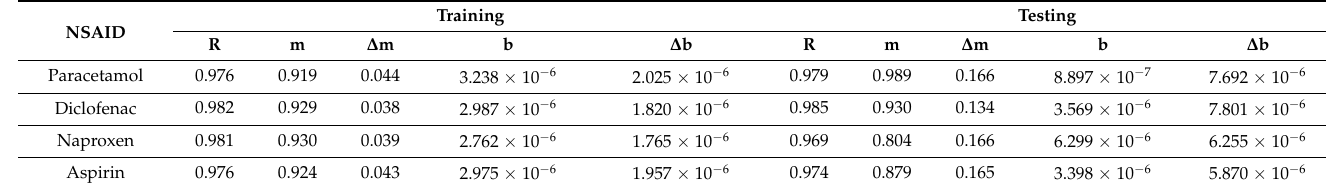
Table 4. Linear regression parameters for the comparison of the obtained vs. expected data with the training and testing data sets using an MLP architecture with two hidden layers. Training Testing